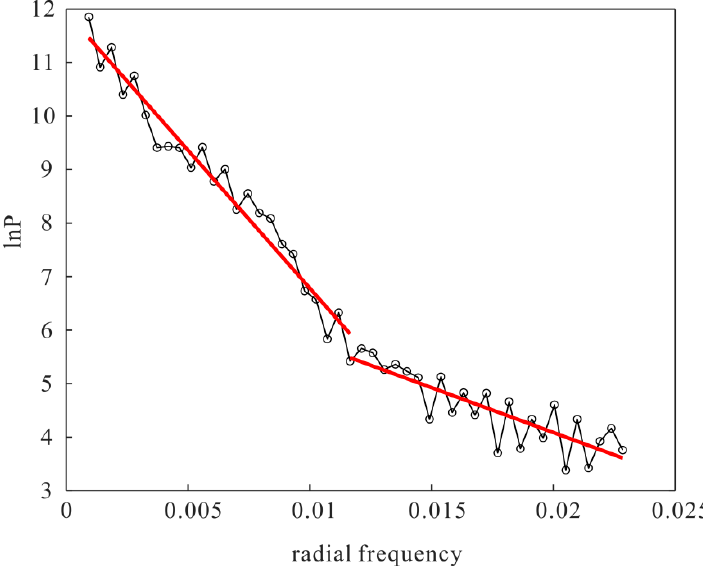
Figure 9. power spectrum of airborne magnetic anomaly.